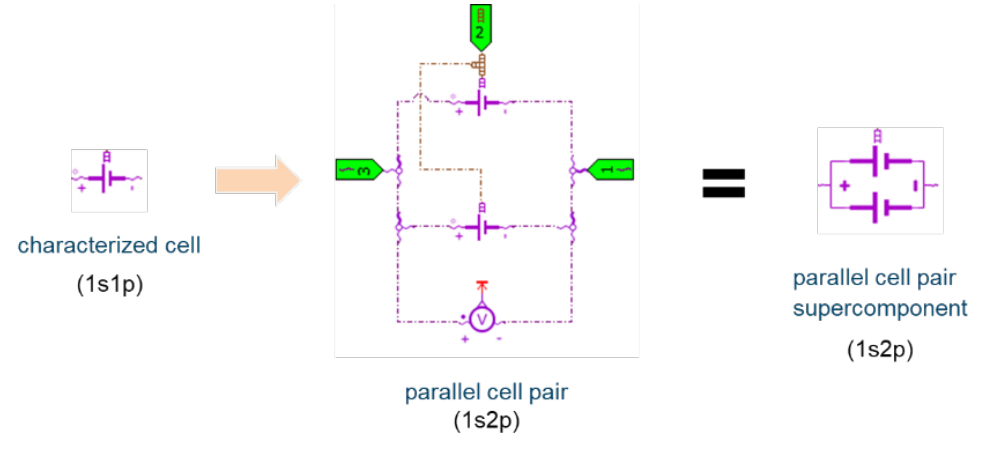
Figure 5. Super-component representing 1s2p cell pair.